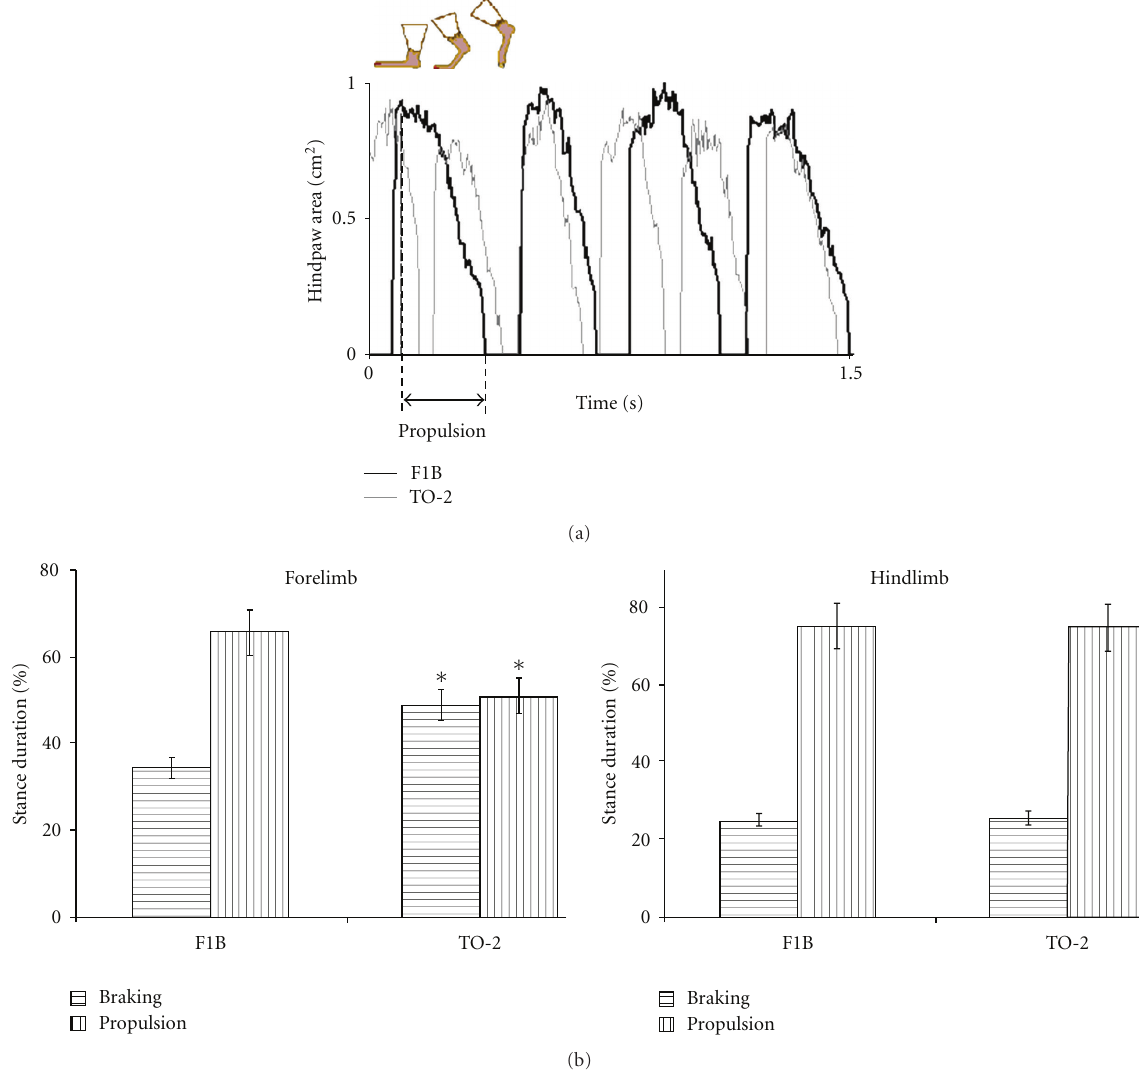
Figure 3: (a) Gait signal of the left hindlimb of a TO-2 hamster superimposed over the gait signal of the left hindlimb of a F1B control hamster. Stride frequency was significantly higher and stride length significantly shorter in TO-2 dystrophic hamsters compared to F1B control hamsters. Propulsion duration (arrows) was significantly shorter in TO-2 hamsters compared to F1B control hamsters. This finding was consistent in hamsters studied at 1 month, 3 months, and 9 months of age. (b) The relative contributions of braking and propulsion to the stance duration of forelimbs and hindlimbs in 9-month-old F1B control hamsters and TO-2 delta-sarcoglycan-deficient hamsters walking at 16 cm/sec. The relative contributions of forelimb braking and propulsion to stance were significantly altered in TO-2 dystrophic hamsters ( ∗ P < . 05, TO-2 versus F1B hamsters). Although propulsion duration was decreased in TO-2 hamsters, the contribution of propulsion to stance was not di ff